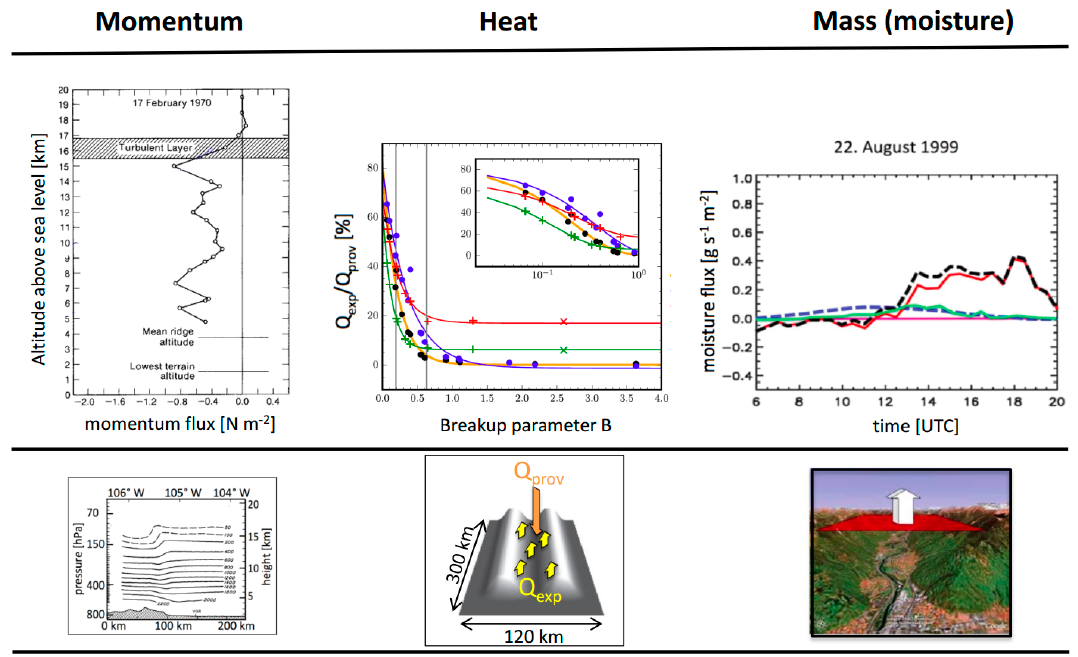
Figure 1. Examples of momentum ( left ), heat ( middle ), and mass ( right ) exchange over mountainous terrain from the literature, with the respective topography shown in the bottom row. Left column: momentum flux profile from airborne observations over the Rocky Mountains during the occurrence of a stationary wave ( top ) and streamfunction isopleths to show the topography ( bottom ) after Lilly and Kennedy [33] (© Copyright (1973) American Meteorological Society (AMS)). Middle column: heat exchange (ratio of exported sensible heat through the top of the valley Q exp and provided heat by solar radiation Q prov ) over an idealized two-ridge valley as a function of the breakup parameter (i.e., a measure of the valley heat deficit). The symbols represent individual simulations and the lines are fits for different initial stability profiles; from Leukauf et al. [34] (© Copyright (2017) American Meteorological Society (AMS)). Right column: daily cycle of moisture flux out of the Riviera Valley (Switzerland). The black dashed line shows the total flux from a high-resolution large-eddy simulation; the blue dashed line shows the total flux from a coarse model; and the solid lines show flow divergence (red), thermal mesoscale circulations (green), and turbulent exchange at the lid (purple); adapted from Rotach et al. [35] (© Copyright (2014) American Meteorological Society (AMS)).